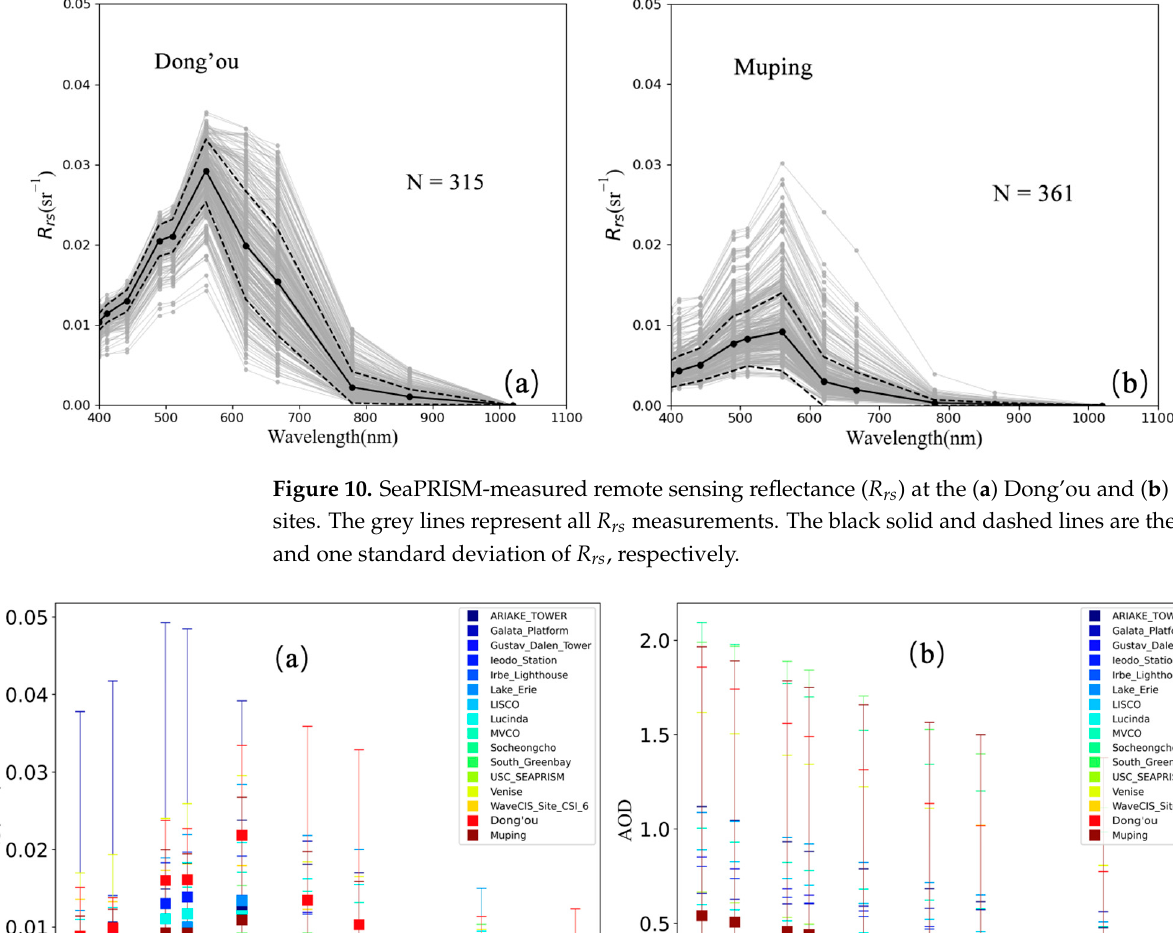
Figure 11. Comparison of mean and standard deviation of ( a ) R rs and ( b ) AOD at 14 AERONET-OC sites, as well as the Dong’ou and Muping sites.